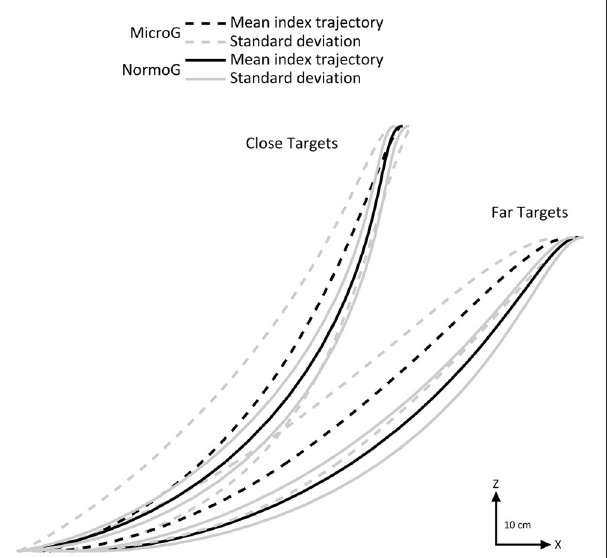
FIGURE 2 | Representative mean endpoint trajectories (black lines) for a typical subject in the sagittal plane in MicroG (dotted line), and NormoG (solid line) for the Close and Far targets. Gray lines represent the positive and negative standard deviations of the mean index trajectories.